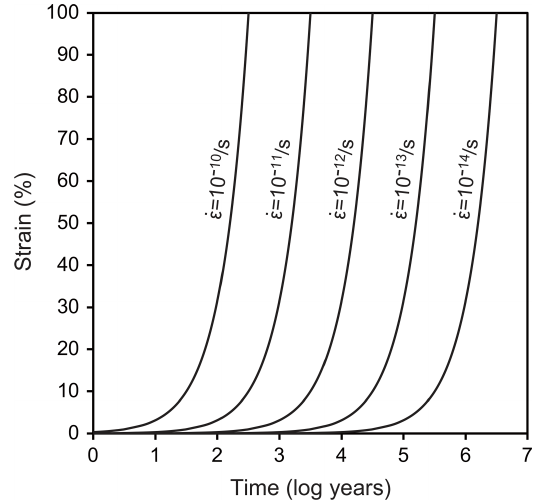
Figure 12. Time evolution of strain under different strain rates. Compare with Fig.